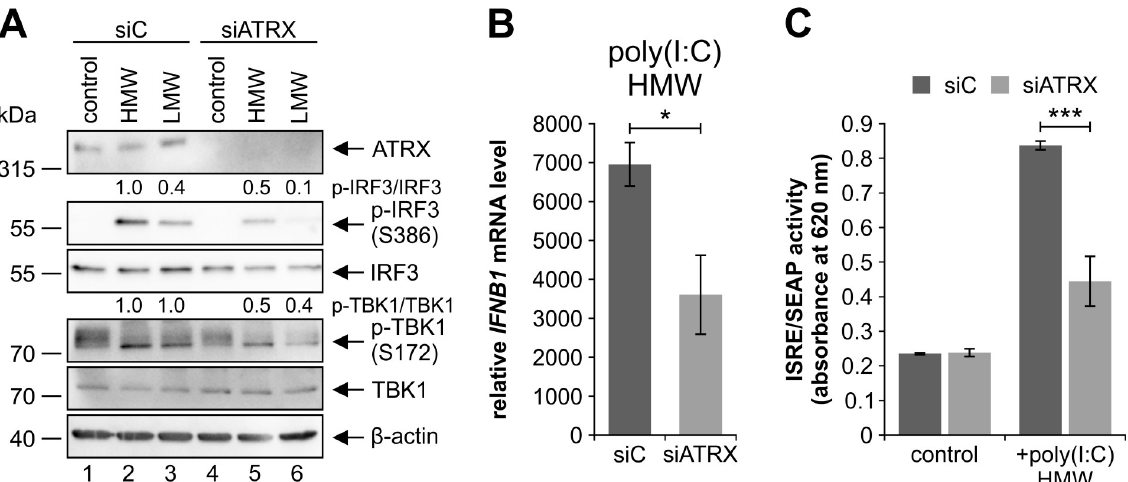
Fig 4. Repression of the RIG-I/MDA-5 signaling pathway in ATRX knockdown HFFs. Stable ATRX knockdown HFFs (siATRX) and respective control cells (siC) were treated with (A) 0.5 μ g/ml poly(I:C) HMW and poly(I:C) LMW, (B) 0.5 μ g/ml poly(I:C) HMW or (C) 0.1 μ g/ml poly(I:C) HMW for 24 h. (A) Cells were harvested for Western blotting to determine the phosphorylation of IRF3 and TBK1; β -actin served as internal loading control. Signal intensities were quantified relative to poly(I:C) HMW-treated siC cells (lane 2). The following antibodies were used: anti-ATRX (39-f), anti-phospho-IRF3 (Ser386) (EPR2346), anti-IRF3 (D6I4C), anti-phospho-TBK1 (Ser172) (D52C2), anti-TBK1 (D1B4), anti- β -actin (AC-15). (B) Total RNAs were prepared and RT-qPCR was performed to determine IFNB1 induction. Depicted values were calculated from triplicates relative to untreated siC cells using GAPDH as a housekeeping gene and are shown as mean ± SD. One out of two independent experiments is shown. Statistical analysis was performed with respective Δ Cq-values using a student’s t -test (unpaired, two-tailed); � p < 0.05. (C) Supernatants were harvested and mixed with HEK-Blue IFN- α / β cells. Type I IFNs in the supernatants were quantitated by measuring SEAP activity produced by HEK-Blue IFN- α / β cells using QUANTI-Blue. Depicted values were derived from triplicates and are shown as mean ± SD. Statistical analysis was performed using a student’s t -test (unpaired, two-tailed); ��� p < 0.001.